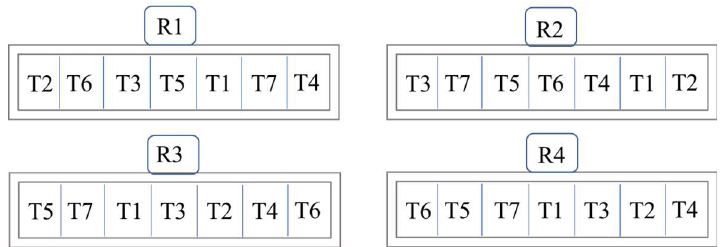
Figure 4. Graphical scheme showing the arrangement of seven treatments repeated four times in a randomized complete block design (RCBD) in the experimental mango orchard at Mango Research Station, Multan,